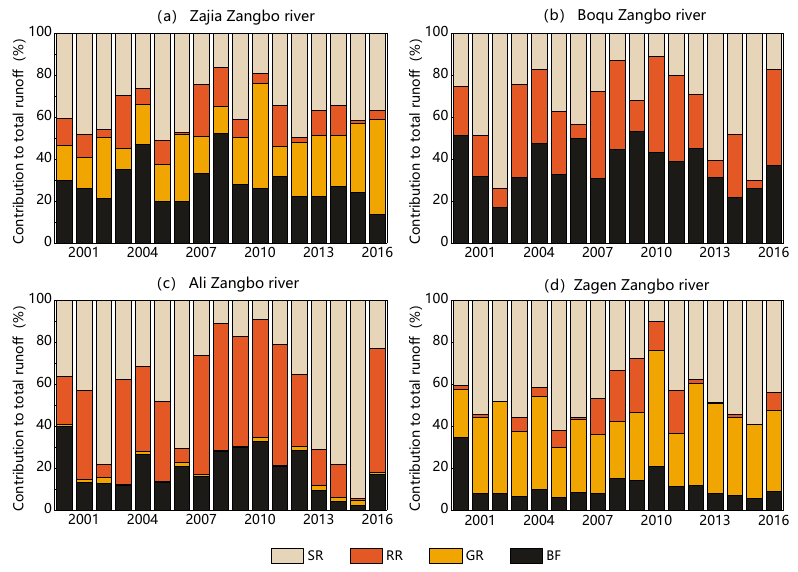
Figure 11. The contribution of BF, GR, RR and SR to total runoff in each sub-basin of Siling Co. ( a ) Zajia Zangbo, ( b ) Boqu Zangbo, ( c ) Ali Zangbo, ( d ) Zagen Zangbo.